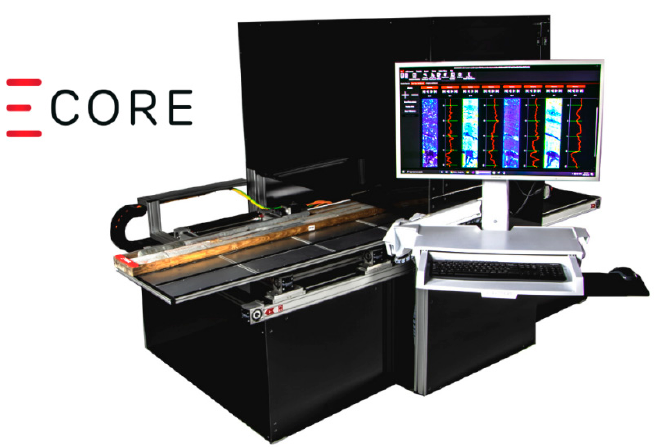
Figure 2. ECORE LIBS drill core scanner.